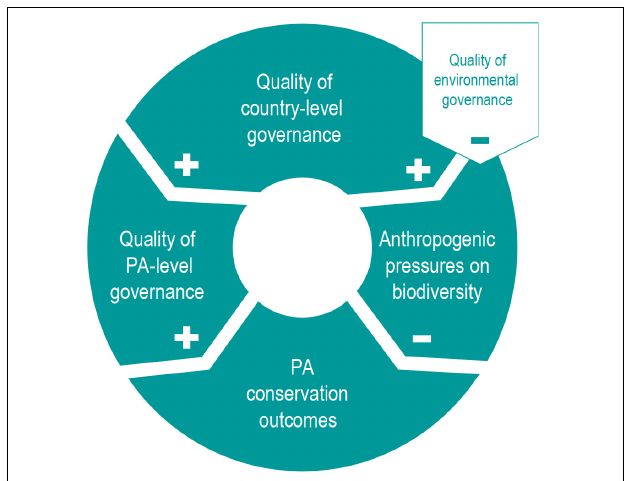
FIGURE 1 | Schematic illustration of potential underlying mechanisms for how the quality of country-level governance indirectly drives PA conservation outcomes. (Simplification of the framework in Eklund and Cabeza, 2017, p.